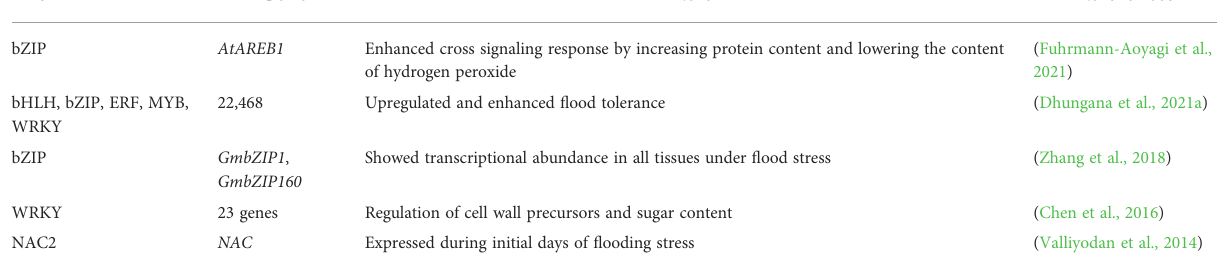
TABLE 2 TFs identi fi ed for fl ood tolerance in soybean. TFs